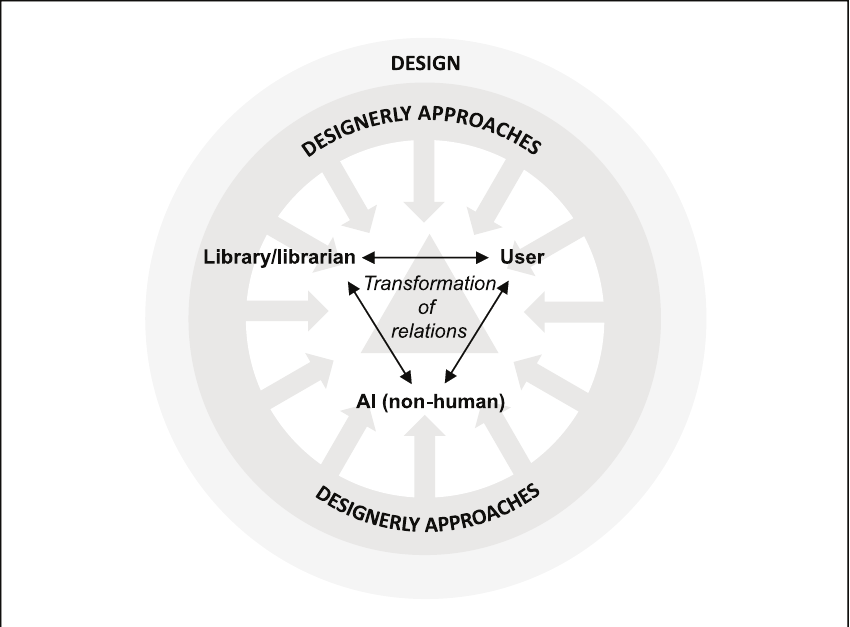
Fig. 4: Designerly approaches framing the transformation of relations between libraries, their users, and